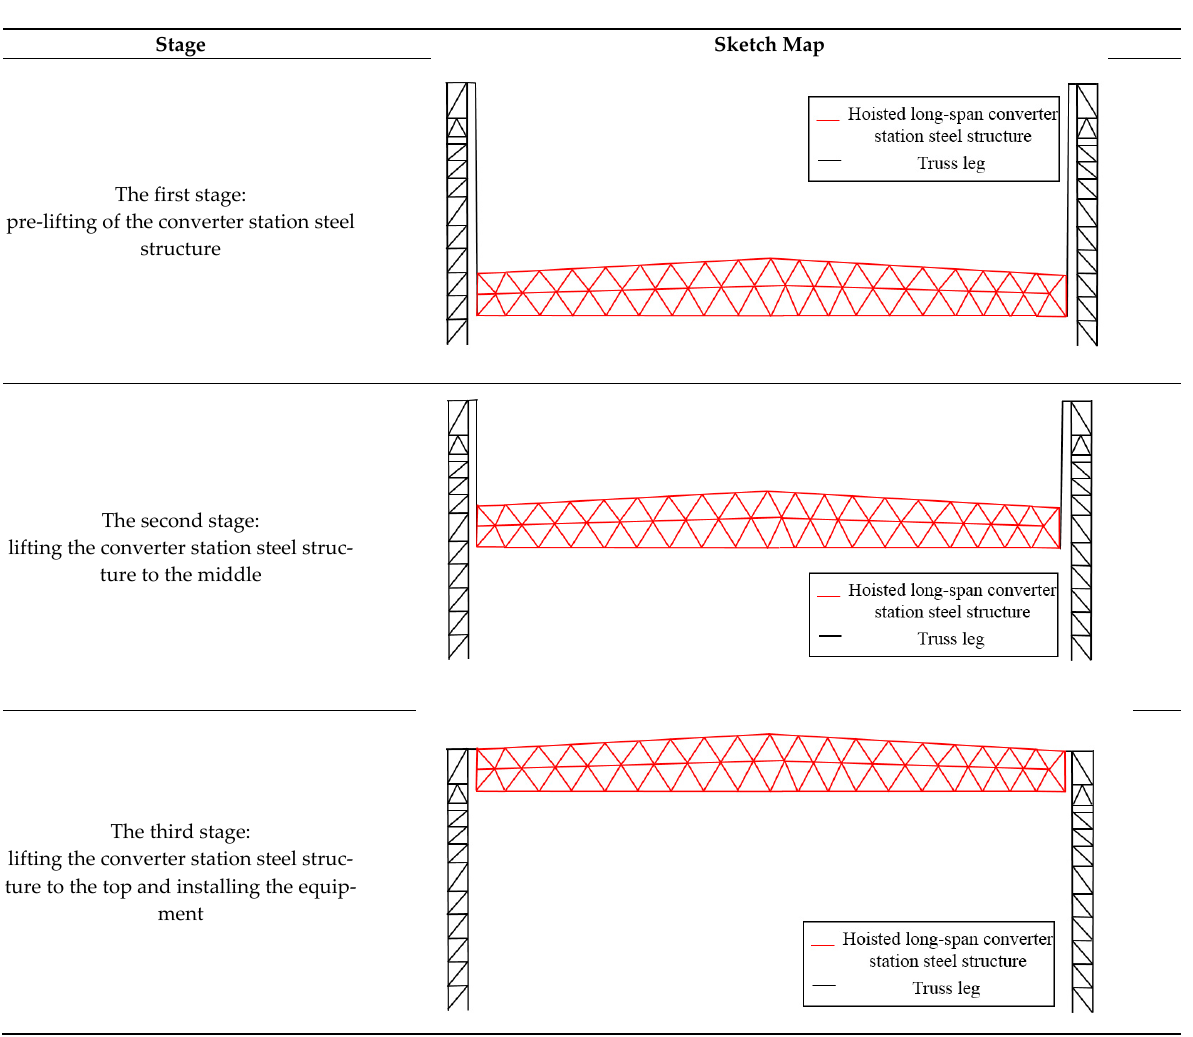
Figure 13. Lifting stage model.